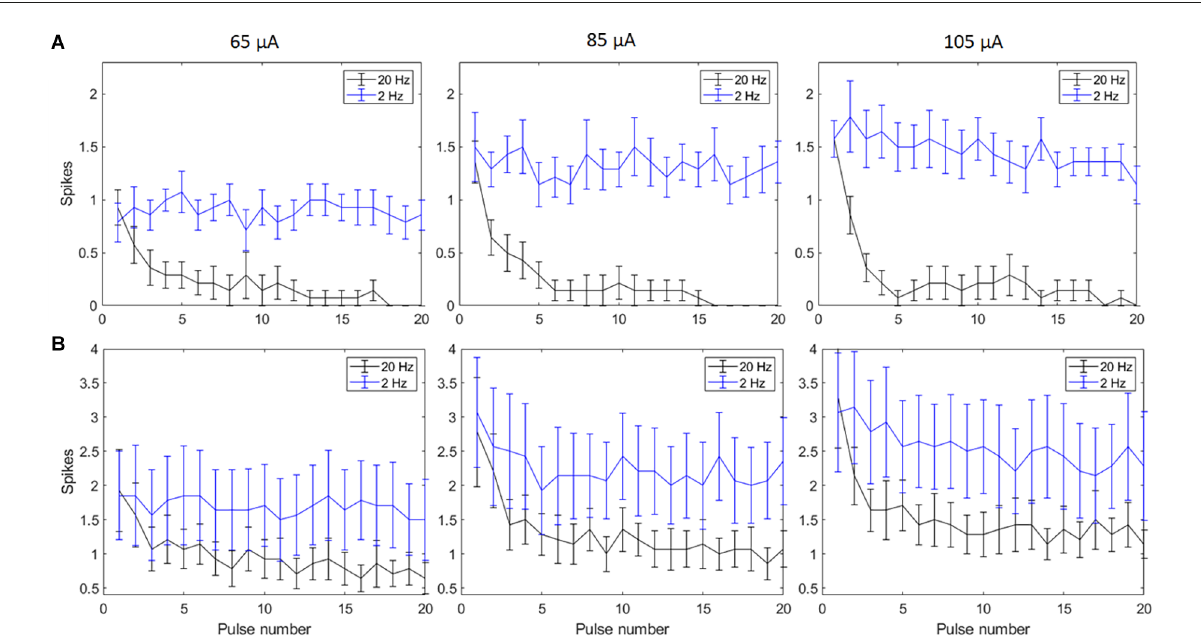
FIGURE2 Spiking activity of RGCs in response to electrical stimulation ( n = 14). The average number of RGC spikes counted in 5 ms (A) and 50 ms bins (B) in response to 20 pulses (0.5 ms/phase) delivered at three current amplitudes (65 µ A, 85 µ A, and 105 µ A) at pulse rates of 2 Hz and 20 Hz. Error bars show the standard error of the mean (SEM).